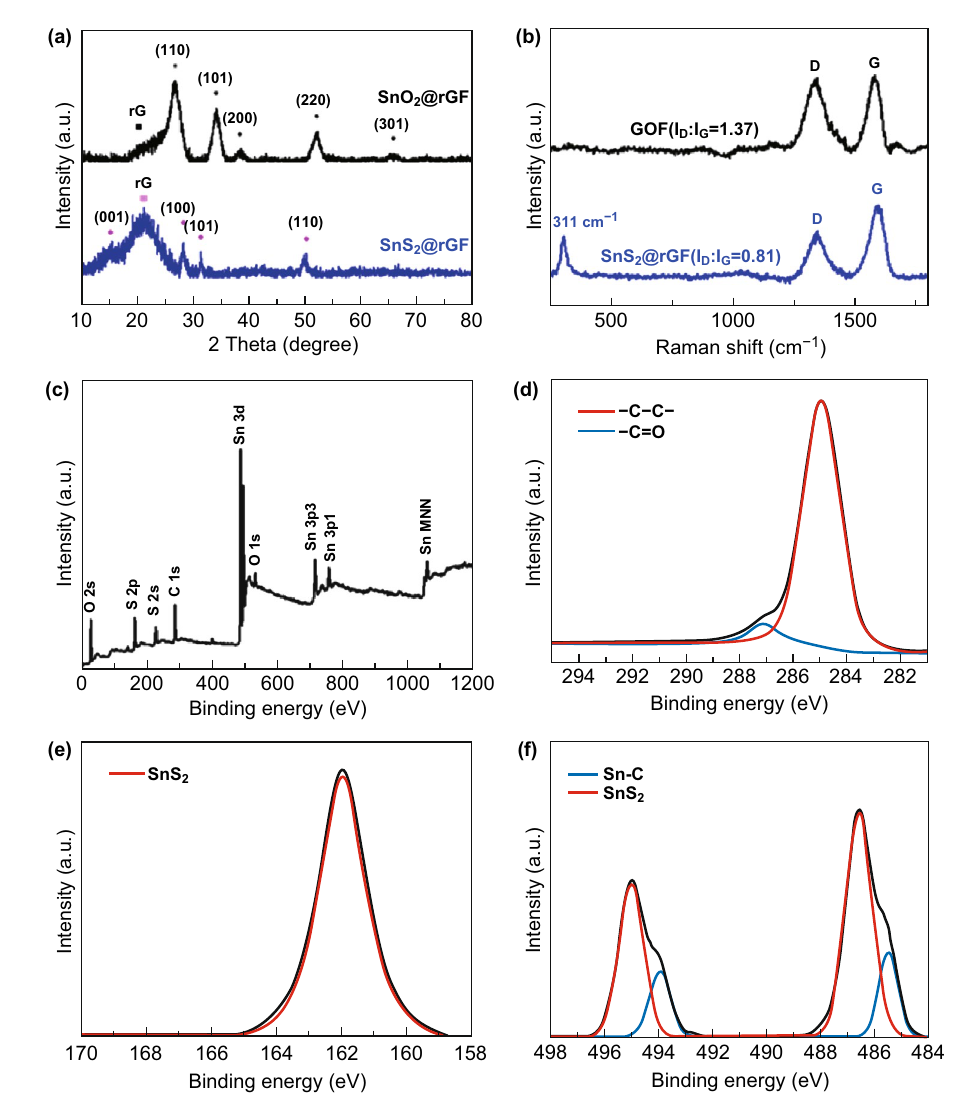
Fig. 3 a Wide‑angle XRD patterns of the SnO 2 @rGF and SnS 2 @rGF fabrics, b Raman spectra of the GOF and SnS 2 @rGF. c–f XPS spectra of the SnS 2 @rGF fabrics, c survey, d C 1 s region, e S 2 p region, and f Sn 3 d narrow scan